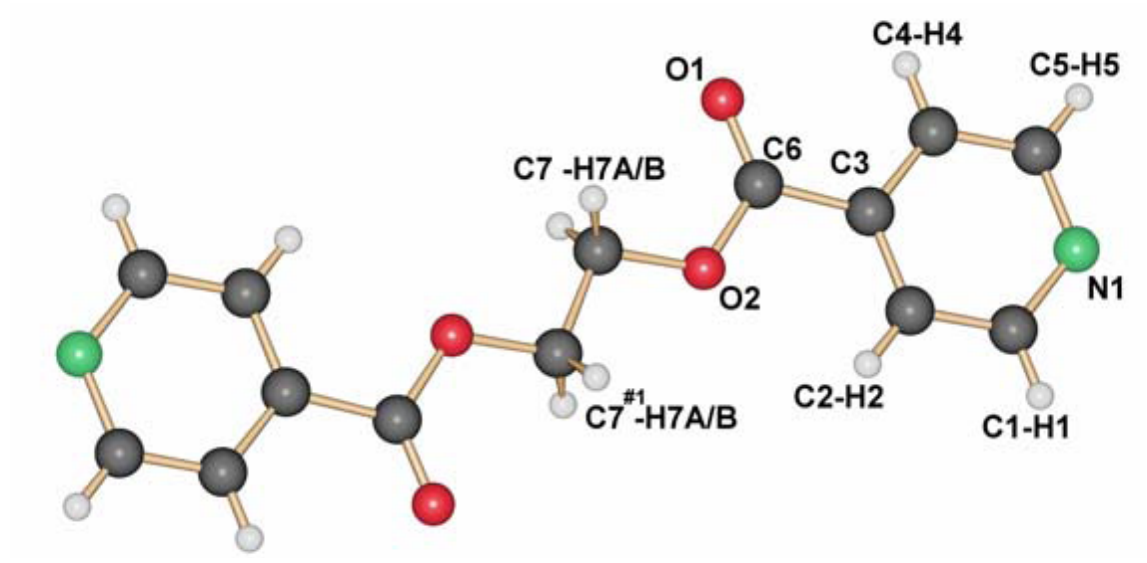
Figure 1. Molecular structure of